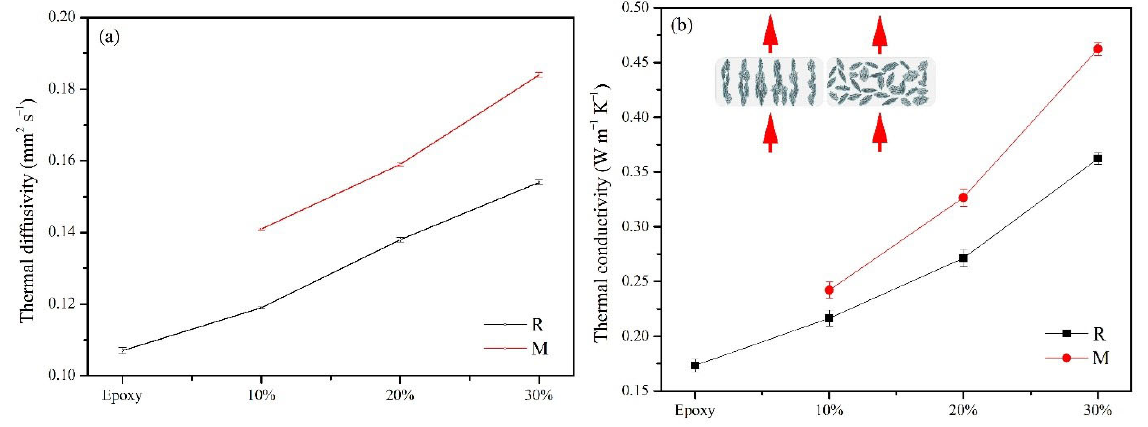
Figure 8. Electrical resistivity of pure epoxy and the NiGNT–epoxy composites with different ratios.